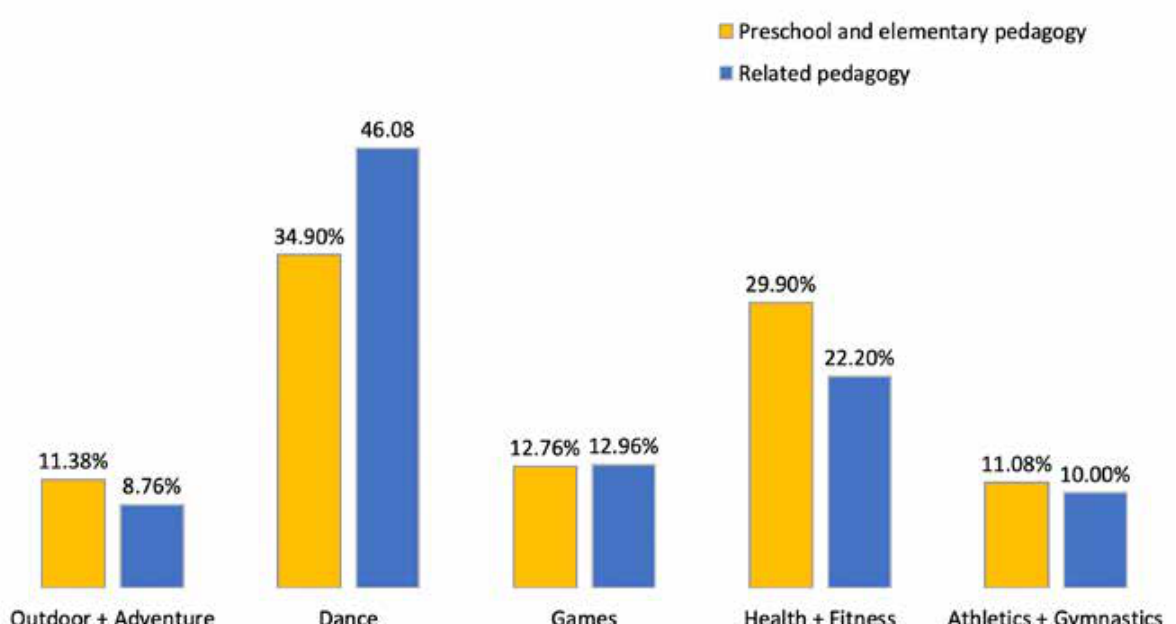
Figure 3. Unpopular teaching activity in primary physical